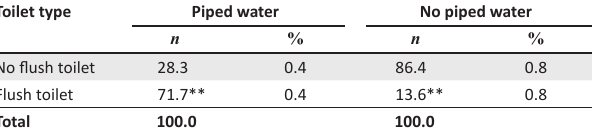
TABLE 1: Cross tabulation showing access to both piped water and flush toilet.